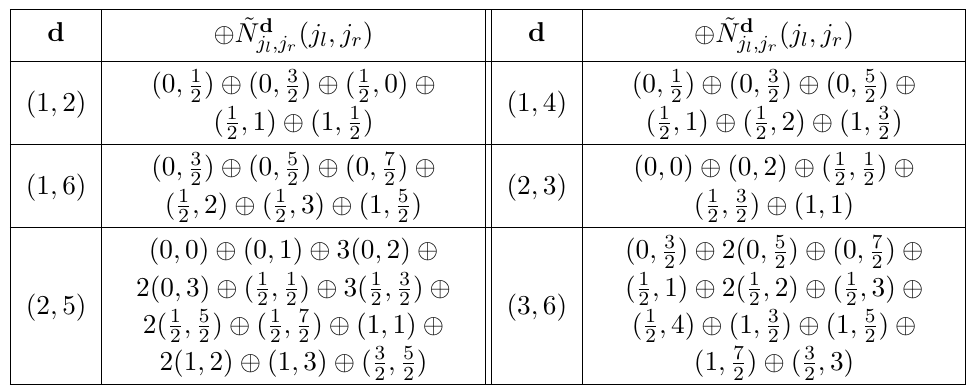
Table 6 . Spectrum of the Wilson loop operator in the rank-3 symmetric representation in the SU(2) π theory for d 1 ≤ 3 and d 2 ≤ 6